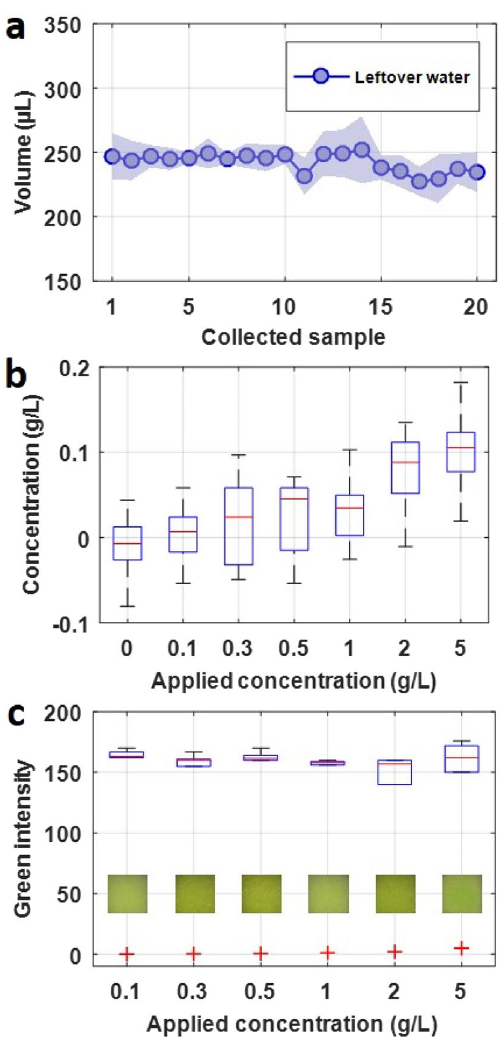
Figure 5. Performance of cleaning the collector and tubing. ( a ) Collected remaining/leftover volume using water as the flushing liquid for each cycle. Total number of cycles, interval period, and total time are 20 cycles, 10 min, and 200 min, respectively. ( b ) Quantification of protein concentration in 20 collected leftover samples via a plate reader for a range of applied concentrations. ( c ) Quantitative intensity analysis of dipstick protein assays. Each experiment is repeated 3 times, represented by standard deviation. Inset images depict the reagent strip color after application of 10 µL of collected leftover flushing